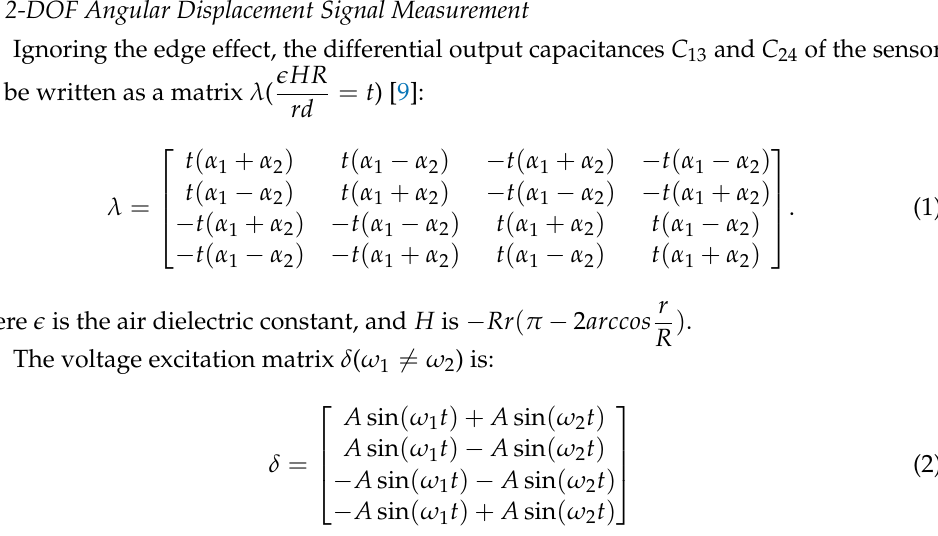
Figure 1. The sensor structure schematic diagram: ( a ) the four-quadrant differential capacitance is balanced; ( b ) the four-quadrant differential capacitance is